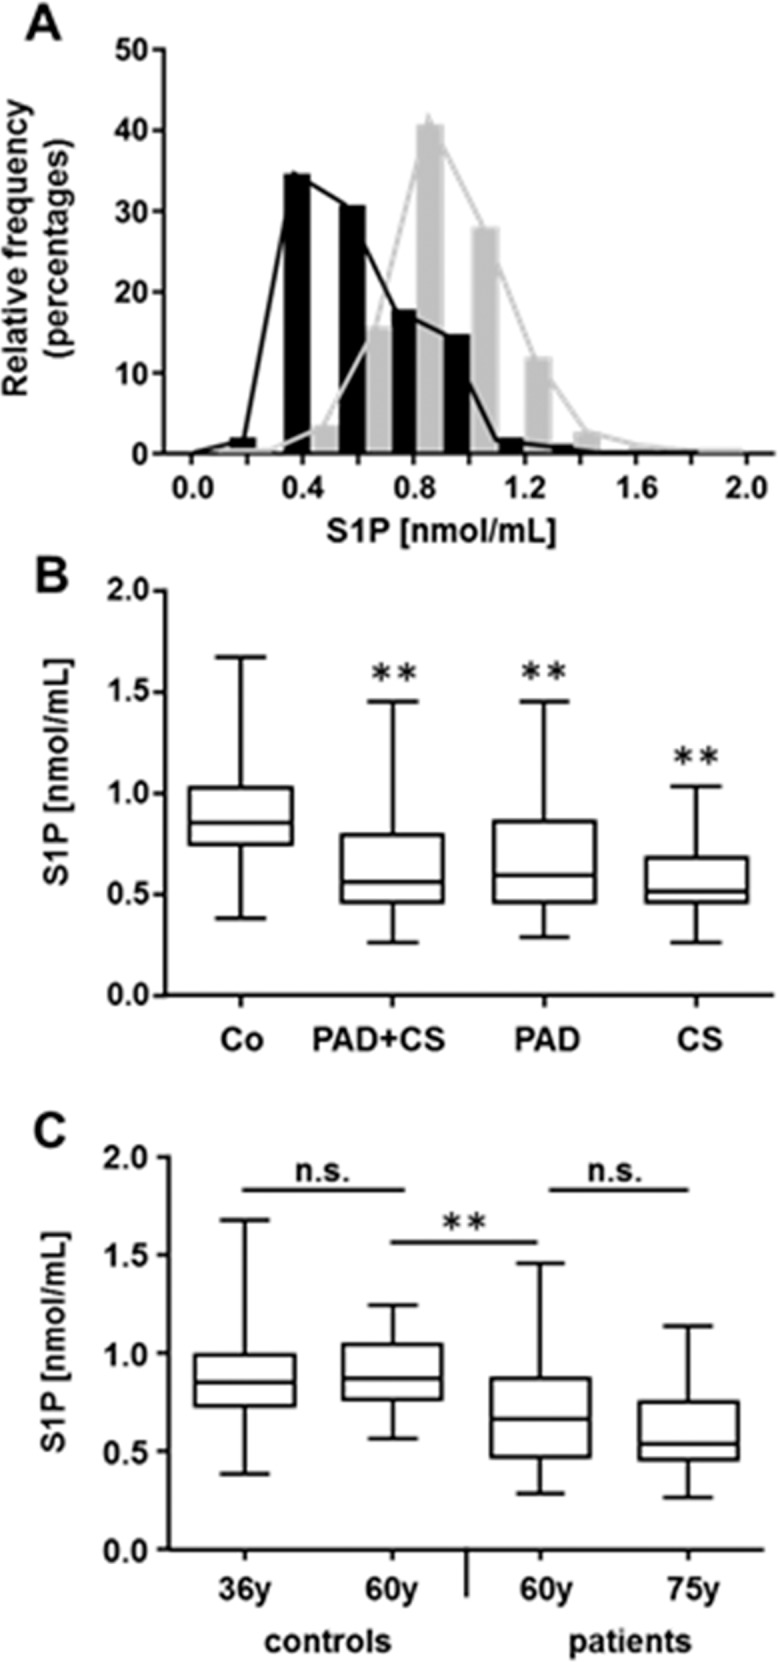
Serum-S1P concentrations in healthy controls and atherosclerotic patients.Serum-S1P was measured in 174 blood donors (controls, Co) and 132 atherosclerotic patients (PAD + CS), 102 with primary PAD and 30 with primary CS. A; frequency histograms (percent of subjects vs. serum-S1P) are shown for controls (grey bars) and atherosclerotic patients (black bars). B; data are presented as median with maximum, minimum and 3rd and 1st quartiles. Statistical analysis was performed by the non-parametric Kruskal-Wallis test with correction for multiple comparisons. **Indicates significance of difference to controls (P<0.001). C; controls and atherosclerotic patients were divided into two groups each to yield one group each with the same median age of 60 years. Four groups with the following median age were formed: Controls (36 years, N = 105 and 60 years, N = 69) and patients (75 years, N = 79 and 60 years, N = 53). Serum-S1P for each group was compared to all other groups using the non-parametric Kruskal-Wallis test with correction for multiple comparisons. ** P<0.001, n.s. = non-significant (P>0.05).